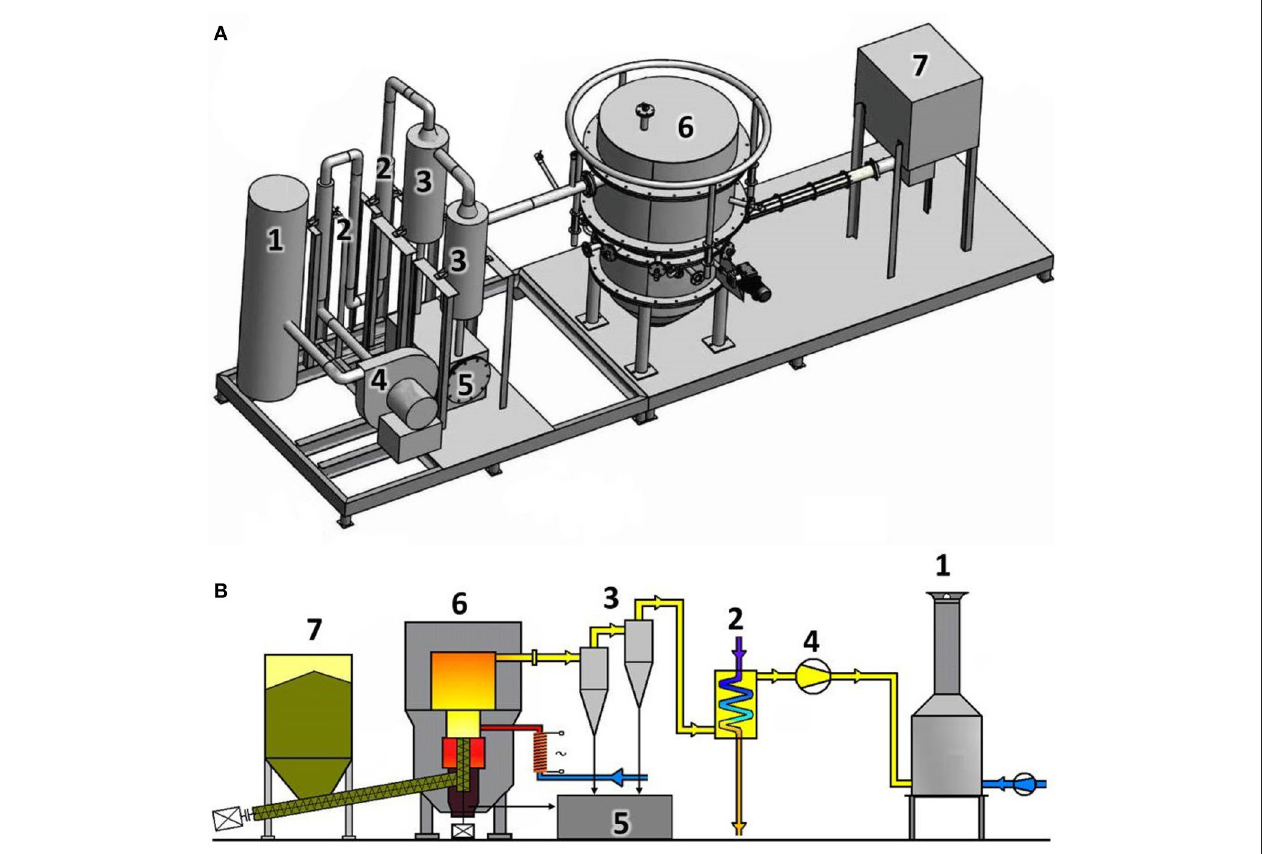
FIGURE 1 | (A) 3D-Schematic (B) 2D-Schematic of the pilot-scale gasifier at the Energy Research Center (1, combustion chamber; 2, coolers; 3, cyclones; 4, air fan; 5, ash bunker; 6, reactor; 7, fuel tank).